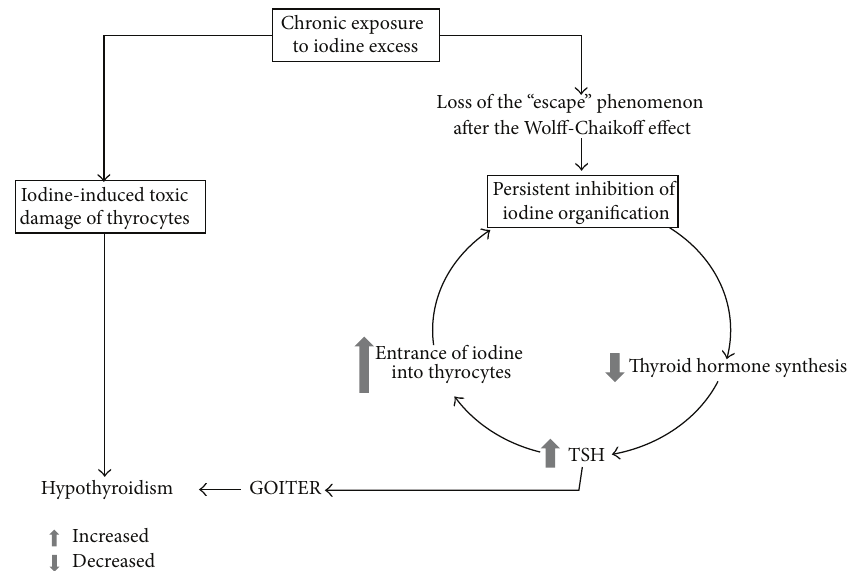
Figure 2: Iodine “excess,” goiter, and hypothyroidism. On the one hand, chronic exposure to iodine excess can cause direct oxidative stress of thyroid cells by activation of the ROS cascade. On the other hand, the loss of downregulation of NIS leads to persistent high intracellular levels of iodine that causes reduction in thyroid hormone